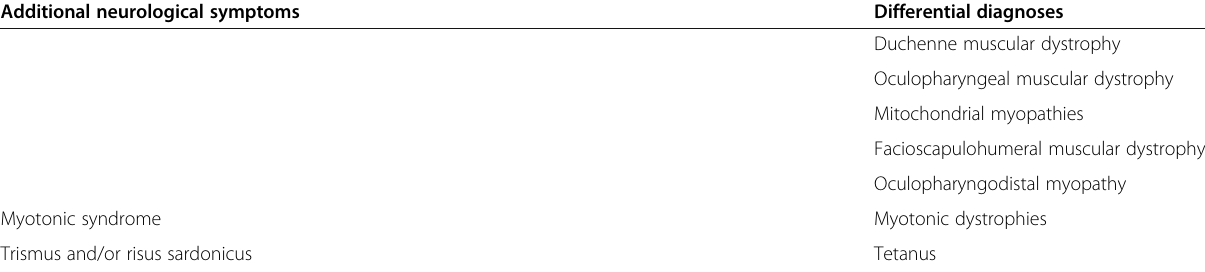
Table 2 Differential diagnosis of neurogenic dysphagia in relation to additional neurological symptoms (according to [65]) (Continued)